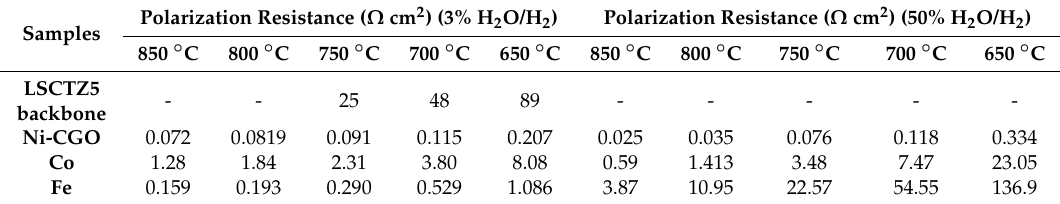
Table 3. Polarization resistances of LSCTZ5 backbone and infiltrated anodes.